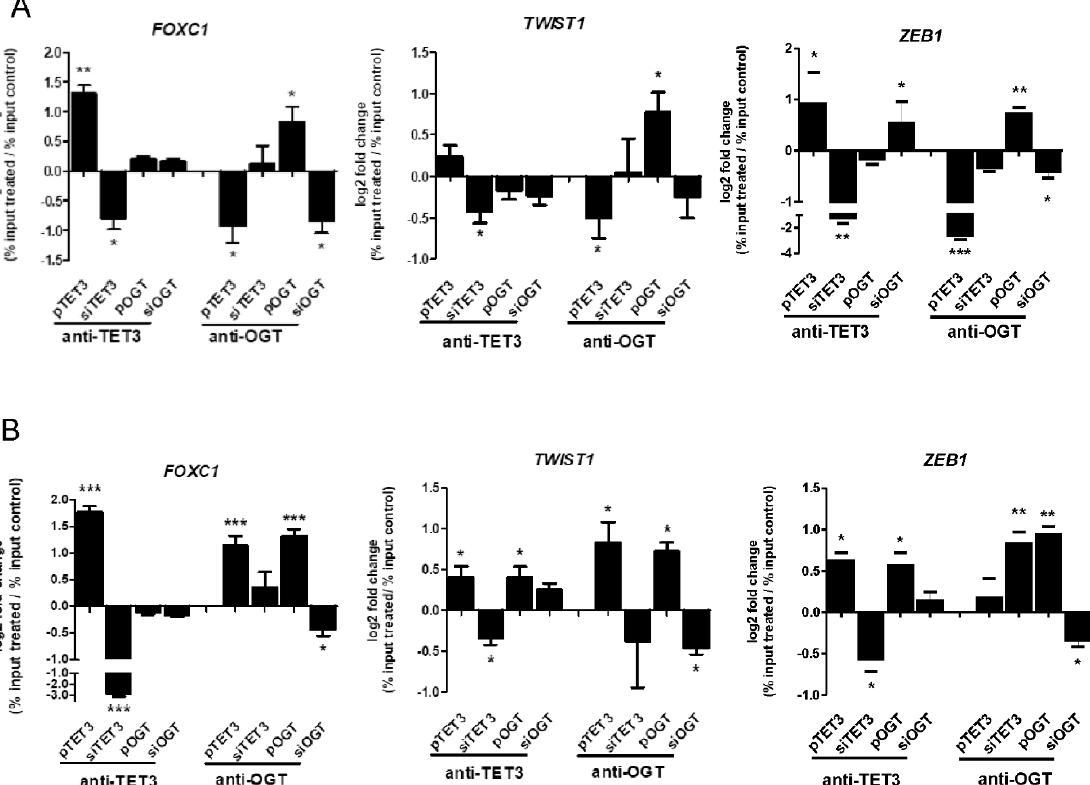
Figure 3. OGT and TET3 binding to chromatin in FOXC1 , TWIST1 , and ZEB1 regions. Chromatin immunoprecipitation (ChIP) analysis was performed for HEC-1A ( A ) and Ishikawa ( B ) endometrial cancer cells treated with plasmid DNA or siRNA with specific antibodies. Differential chromatin enrichment was quantified using real-time quantitative PCR. The results were calculated as % input (% input = % input of specific antibodies probes—% input mock IgG) and are presented as a log2fold change (Fold change = % input of treated cells sample/% input of control cells sample). Data show mean ± SE, ( n = 4) * p < 0.01, ** p < 0.001, *** p < 0.0001.